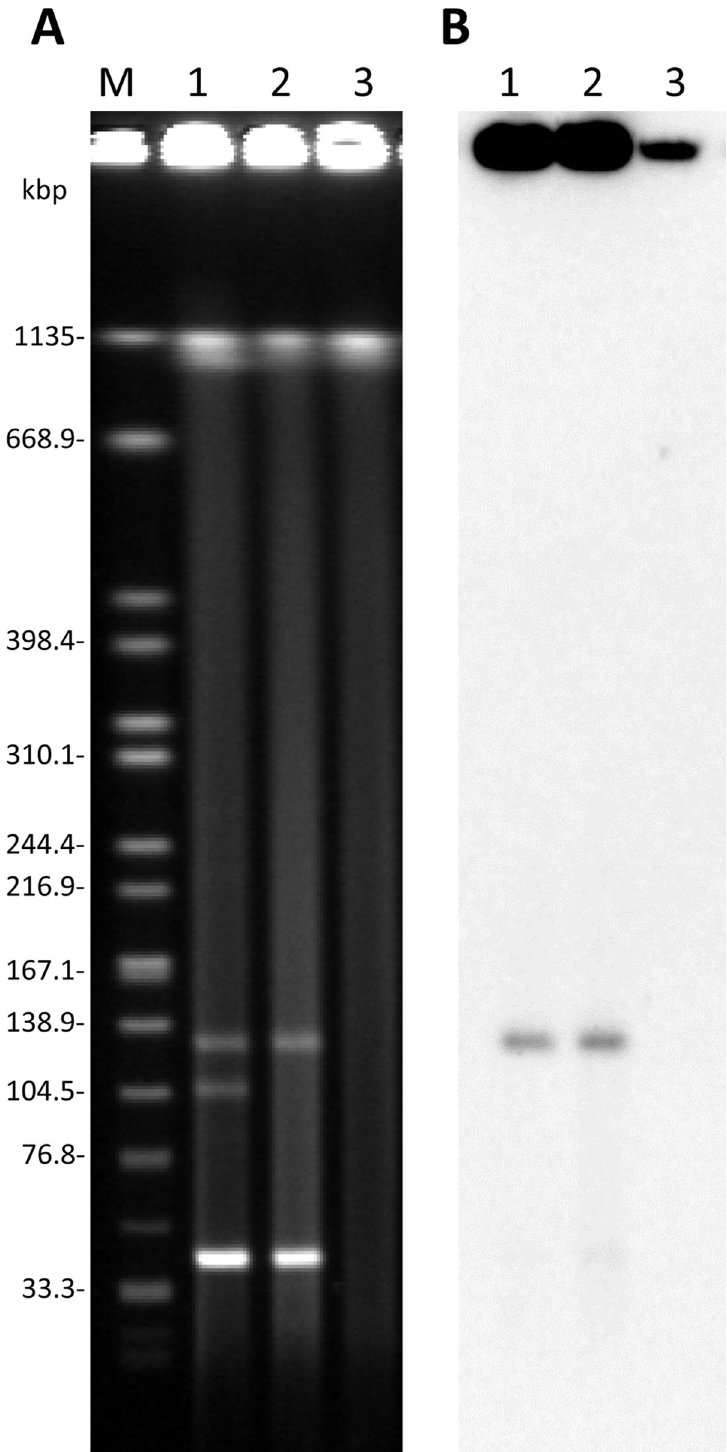
Fig 1. S1-PFGE (A) and Southern blot hybridization detection (B) of bla KHM-1 . Lane 1, E . hormaechei subsp. hoffmannii isolate OIPH-N069; Lane 2, transconjugant TcN069; Lane 3, E . coli K-12 DH5 α (recipient); Lane M; Xba I- digested Salmonella enterica serovar Braenderup strain